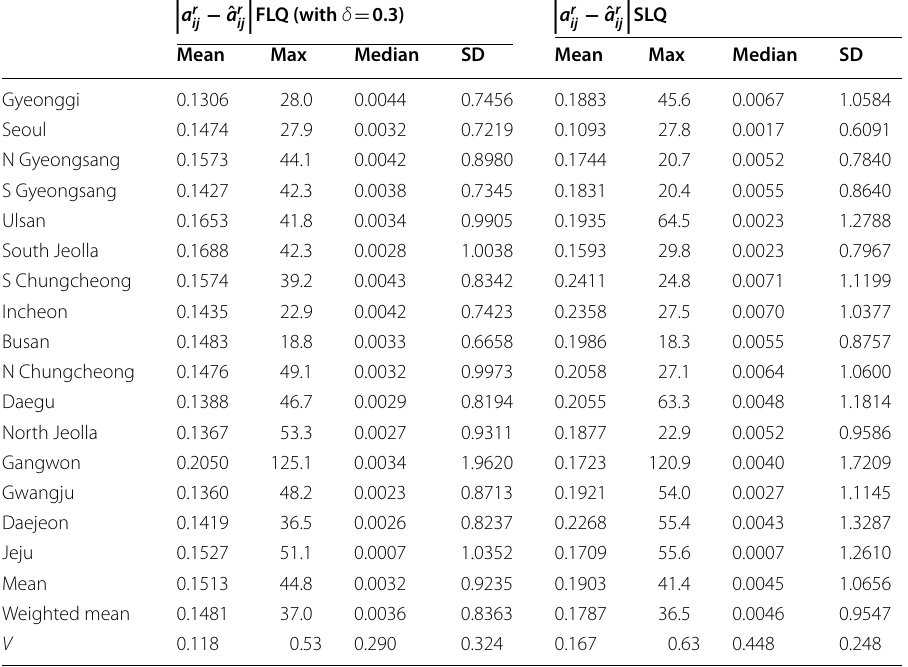
100) between the observed and estimated input × 0.3) and SLQ =